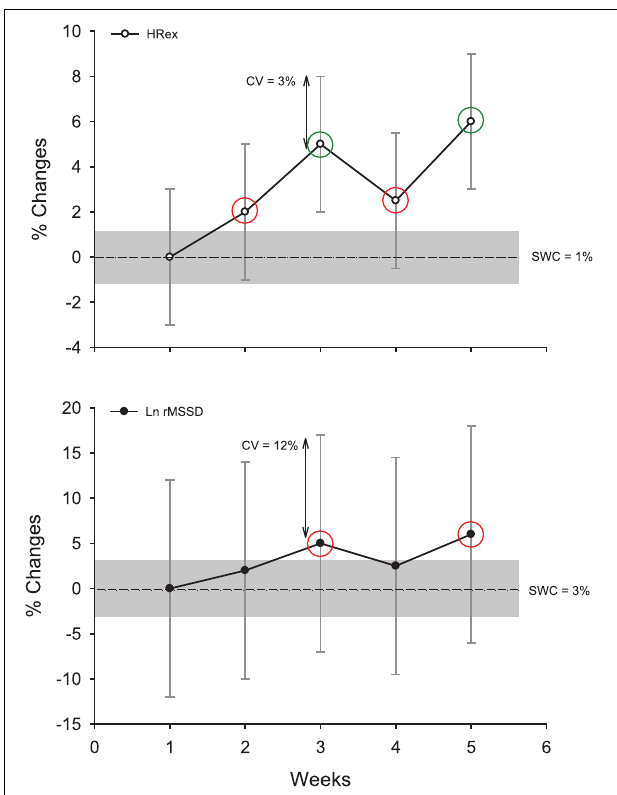
FIGURE 7 | Example of the decision process to interpret changes in exercise heart rate (HRex) and the logarithm of the square root of the mean of the sum of the squares of differences between adjacent normal R-R intervals (Ln rMSSD) in an individual athlete, while accounting for the uncertainty or the noise of each measure (expressed as a coefficient of variation, CV) and the so-called smallest worthwhile change (SWC; Table 2, where the gray areas represent trivial changes). Green circles show clear and substantial changes; red circles show unclear changes although being out of the “trivial zone” (the CV overlaps both zero and the SWC). Note that despite similar percentage changes for the two HR-derived indexes, only changes in HRex are interpreted as